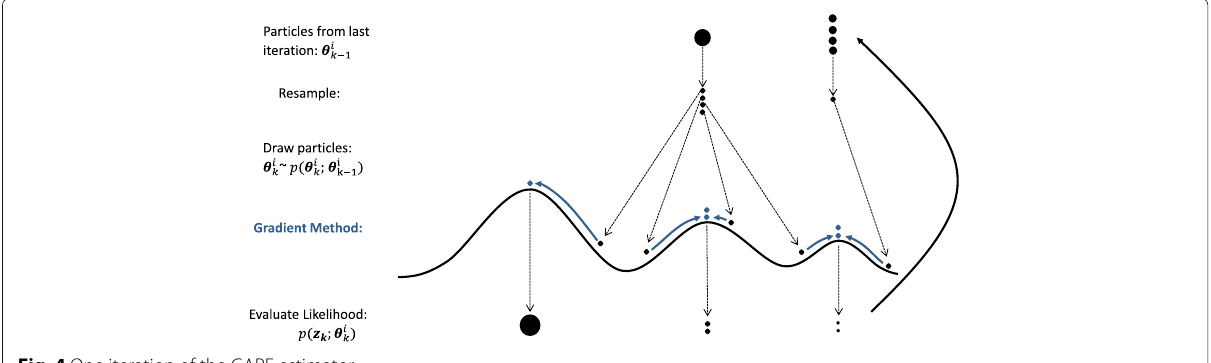
Fig. 4 One iteration of the GAPF